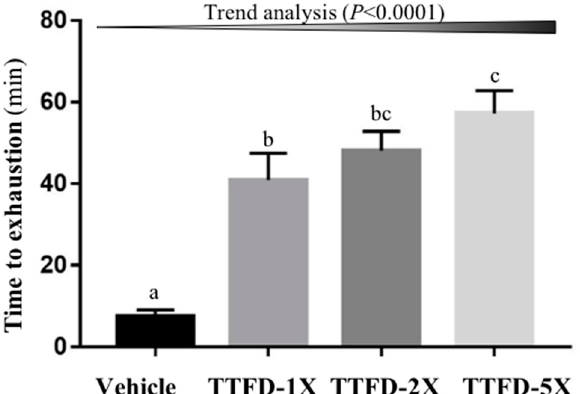
Figure 3. Effect of 4-week TTFD supplementation on exhaustive swimming time. Data are mean ± SEM for n = 10 mice per group. Columns with different letters (a, b, c) are significantly different at P < 0.05.